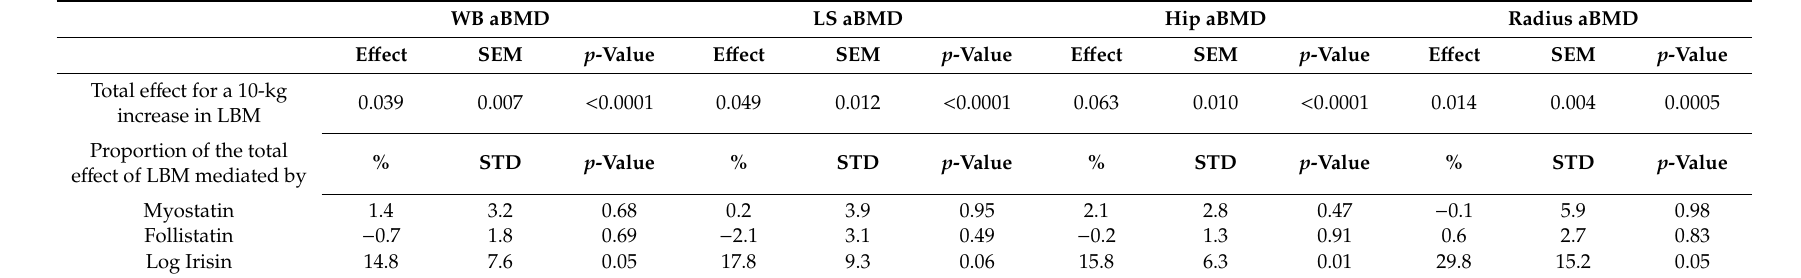
Table 3. Mediation e ff ects of myokines on areal bone mineral density, adjusted for height and